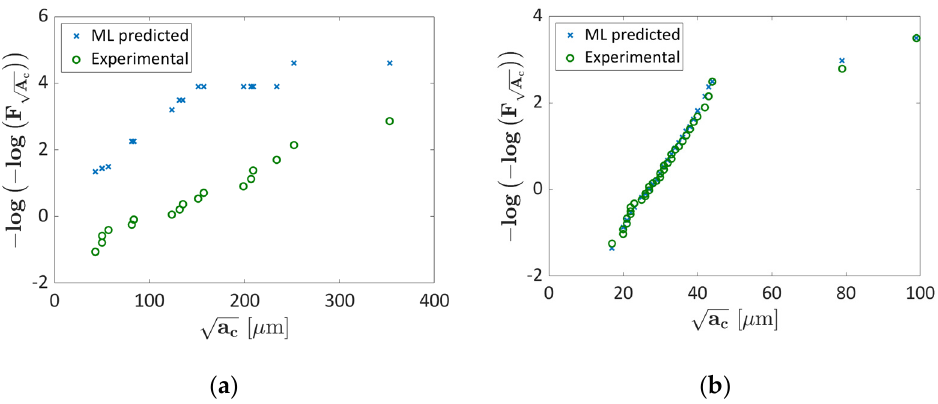
Figure 14. Gumbel plot for the k = 1 fold considered for the validation; ( a ) validation dataset; ( b ) training data.